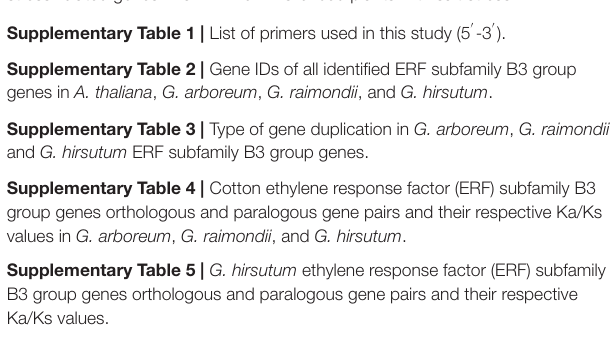
Supplementary Figure 1 | Conserved amino acid sequence in three cotton species, such as G. arboreum , G. raimondii , and G. hirsutum . Supplementary Figure 2 | Collinearity analysis of the GhERF subfamily B3 group genes. Collinearity analysis of G. hirsutum ERF subfamily B3 group genes among and within the A- and D-subgenomes is represented by the red lines. Supplementary Figure 3 | Sequence alignment among ERF13 proteins. Sequence alignment of A. thaliana and G. hirsutum ERF13 proteins depicted β -1, β -2, β -3, and α -helix regions, and a putative AP2/ERF domain (red region). Supplementary Figure 4 | Transcript levels and hypocotyl length in GhERF13.12 transgenic Arabidopsis. (A) Transcript levels of GhERF13.12 in transgenic Arabidopsis as measured by RT-PCR. (B) Determination of hypocotyl length in GhERF13.12 transgenic Arabidopsis with or without ACC in MS. Supplementary Figure 5 | Phenotype of virus-induced gene silencing (VIGS) plants and transcript levels of salt stress related genes. (A) Silenced phenotype of positive control seedlings during VIGS experiment. (B) Transcript levels of salt stress-related genes in GhERF13.12 -silenced plants with salt stress. Supplementary Table 1 | List of primers used in this study (5 ′ -3 ′ ).